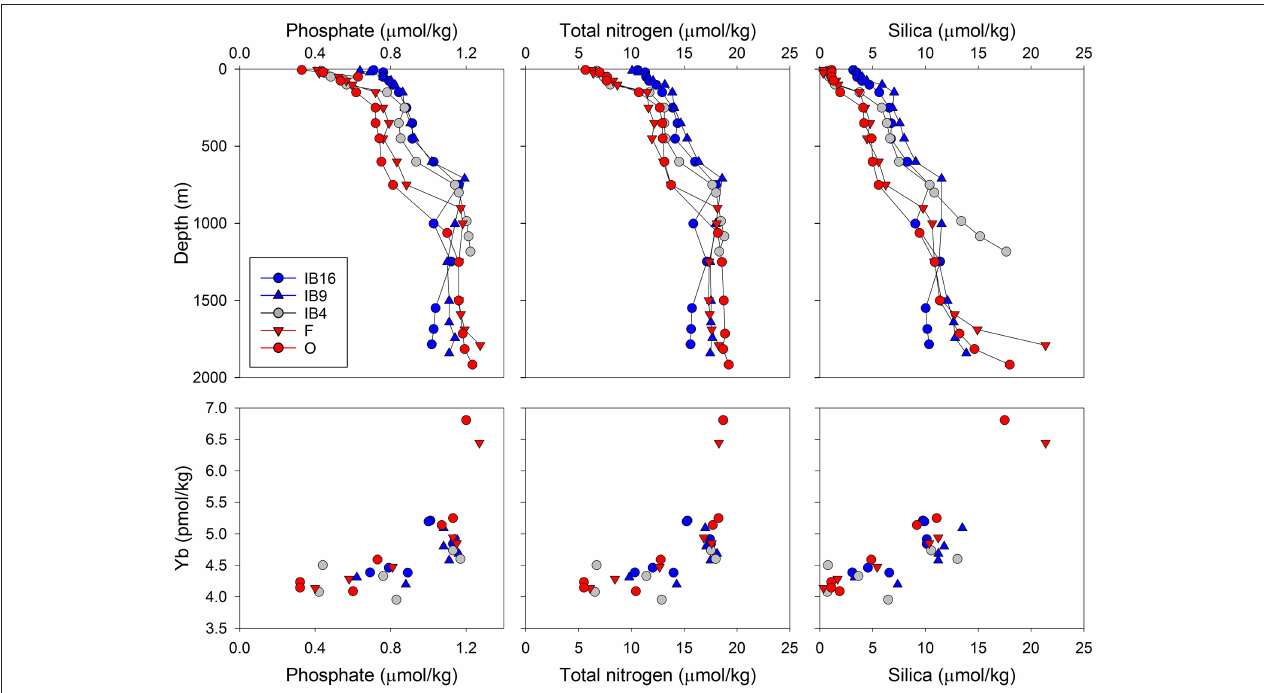
FIGURE 11 | Depth variation of the nutrient concentrations ( µ mol/kg) at the 5 open ocean stations in this study. The lower panels show variation in Yb concentration (pmol/kg) vs. each of the three nutrients (phosphate, total nitrogen,